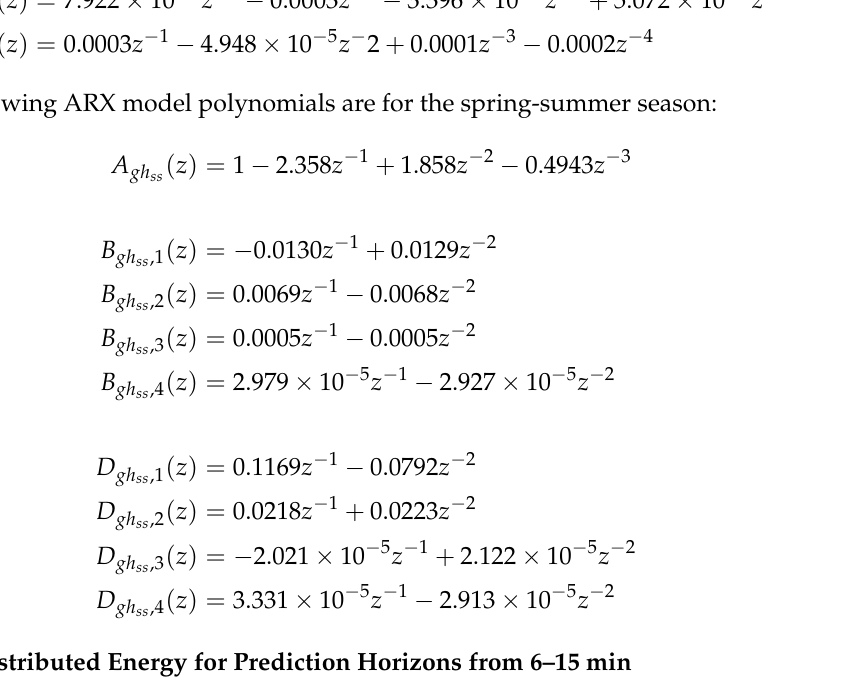
Table A1. Energy (kW) distributed for prediction horizons from 6–15 min with separation intervals